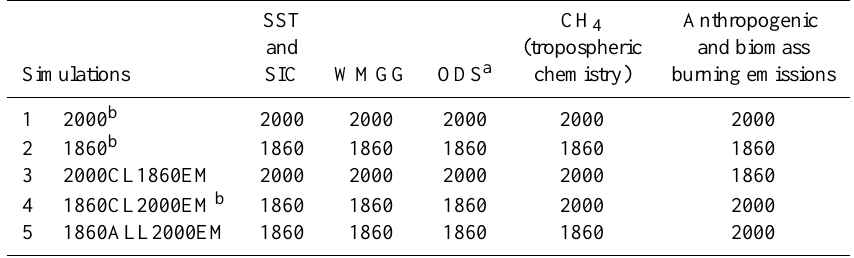
Table 1. Model simulation configurations. All simulations are run for 11 yr with the first year used for spin-up (SST: sea surface temperature; SIC: sea ice; WMGG: well-mixed greenhouse gases; ODS: ozone-depleting substances). SST CH 4 Anthropogenic and (tropospheric and biomass Simulations SIC WMGG ODS a chemistry) burning emissions 2000